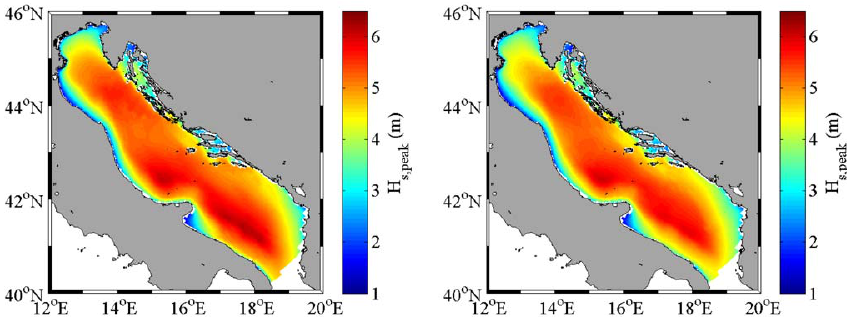
Fig. 12. 5-yr return significant wave height H s (in meters). Numerical simulations of the present climate (left) and the future scenario (right) are shown.